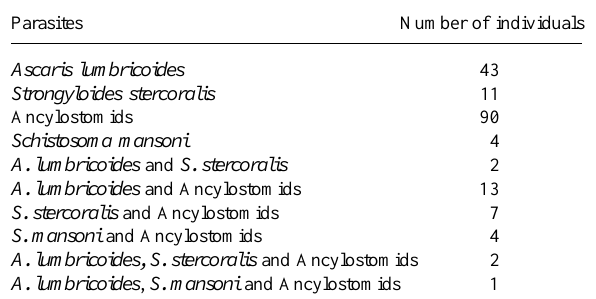
Table II - Distribution of different parasites among individuals in a sample from Bambui, MG, Brazil. Parasites Number of individuals Ascaris lumbricoides